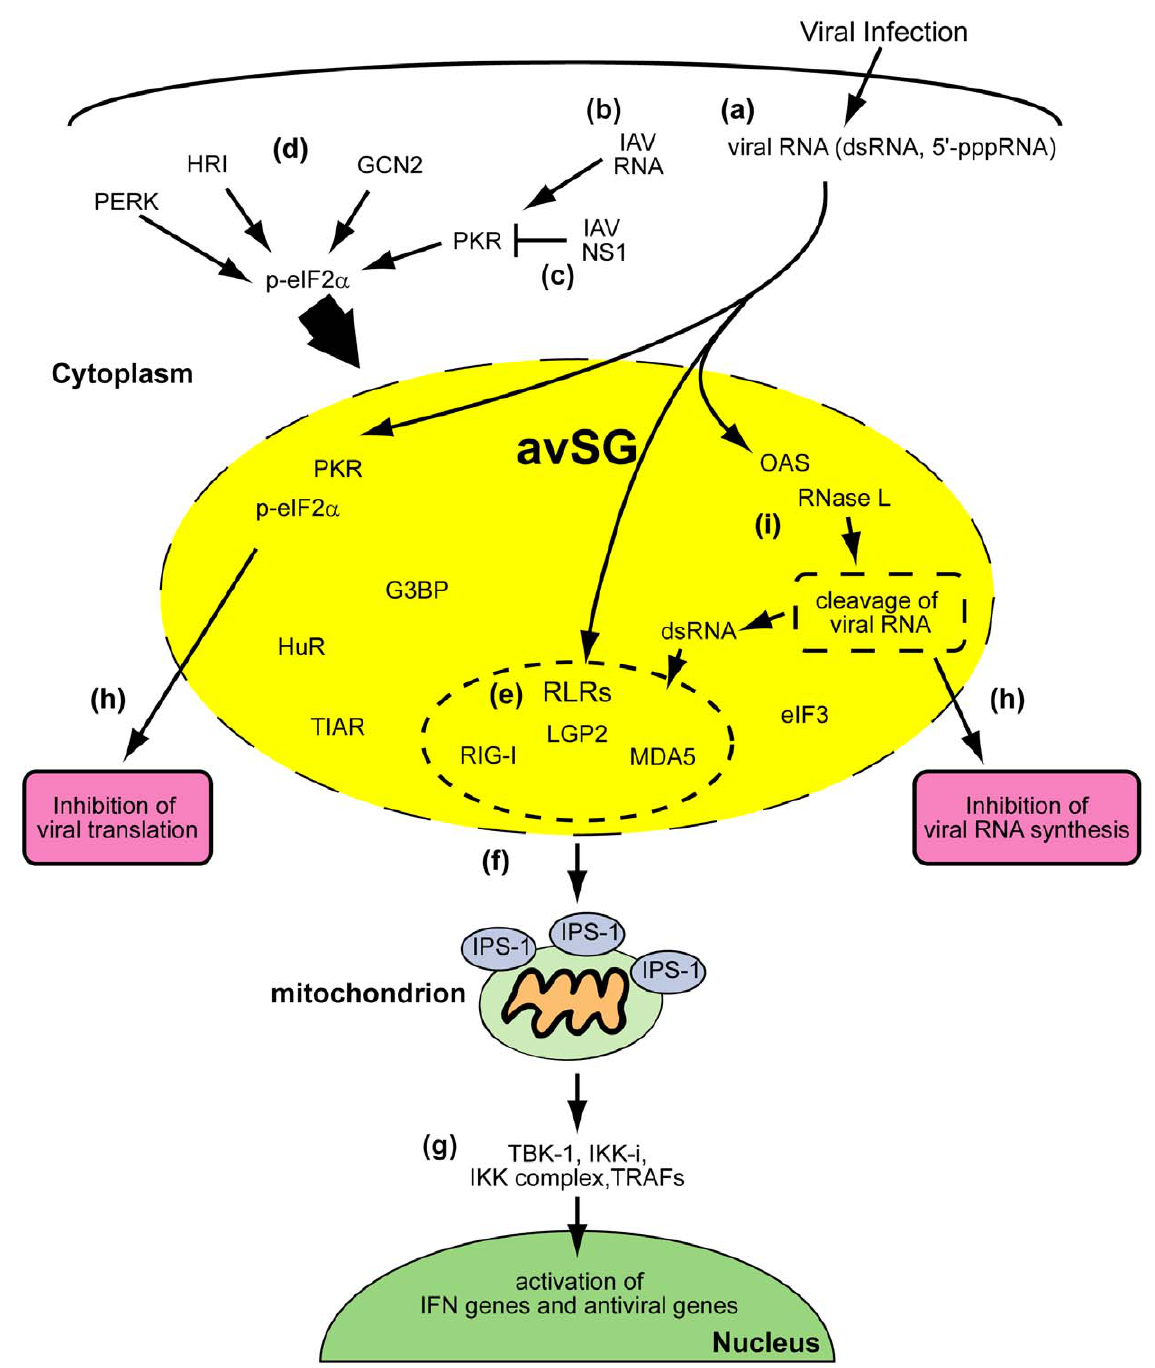
Figure 9. avSGs and innate antiviral responses. Viral infections generate RNA with non-self-signatures such as a 5 9 -tri-phosphate or double- stranded structure ( a ). In the case of IAVA¨NS1, PKR is critical for the formation of avSGs ( b ). Wild-type IAV inhibits formation of avSGs by the actions of the NS1 protein (c ). Some other viruses may activate different eIF2a´ kinases, such as GCN2, PERK, and HRI, to produce functional avSGs ( d ). avSGs are composed of SG markers and other RNA-binding proteins including RLRs, antiviral proteins (PKR, OAS, and RNase L) and viral RNA. Within avSGs, viral RNA could be sensed by RLRs to trigger antiviral signaling ( e ). Activated RLRs recruit mitochondrial IPS-1 via CARD-CARD interactions ( f ). IPS-1 serves as another platform for TRAFs and protein kinases, TBK-1, IKKi and IKK complex, to activate target genes ( g ). The antiviral proteins are activated by viral RNA to block viral RNA synthesis and translation ( h ). Moreover, OAS-RNase L system may produce dsRNA to amplify the RLR signaling ( i ). doi:10.1371/journal.pone.0043031.g009 (AVG) [47]. They also reported that MEFs lacking the AVG Vaccinia virus A¨ E3L, lacking E3L genes, generated a granular-like component TIA-1 exhibited increased Vaccinia viral replication, structure distinguished from a granule termed antiviral granule suggesting that AVG is critical for antiviral host responses. These